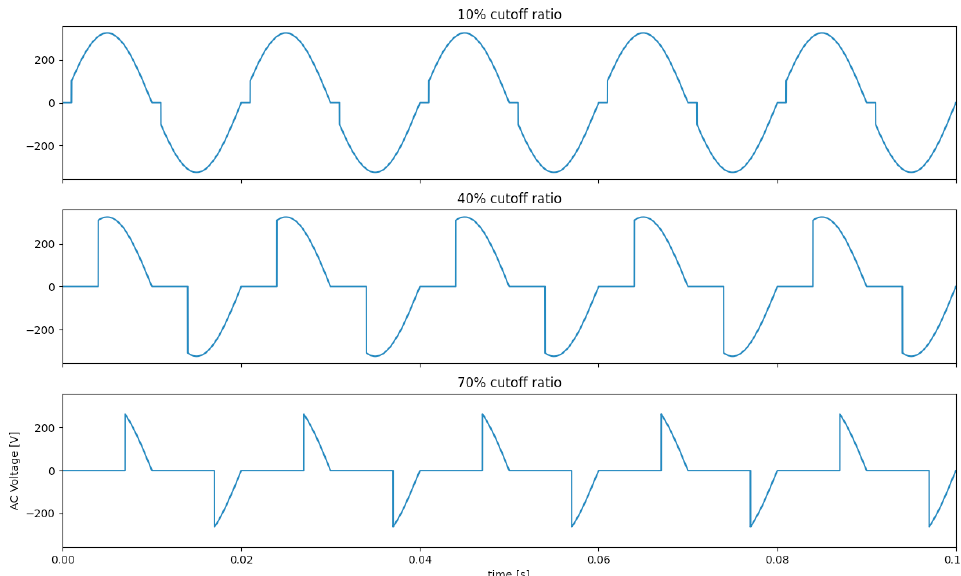
Figure 1. Voltage cutoff method used by the Smart Plug to extract a characteristic response from the connected electrical load. The voltage curves are shown for cases when different cutoff ratios are applied. The leading part of the sinusoidal is cut, and the start is synchronized to the zero crossing of the AC voltage curve.